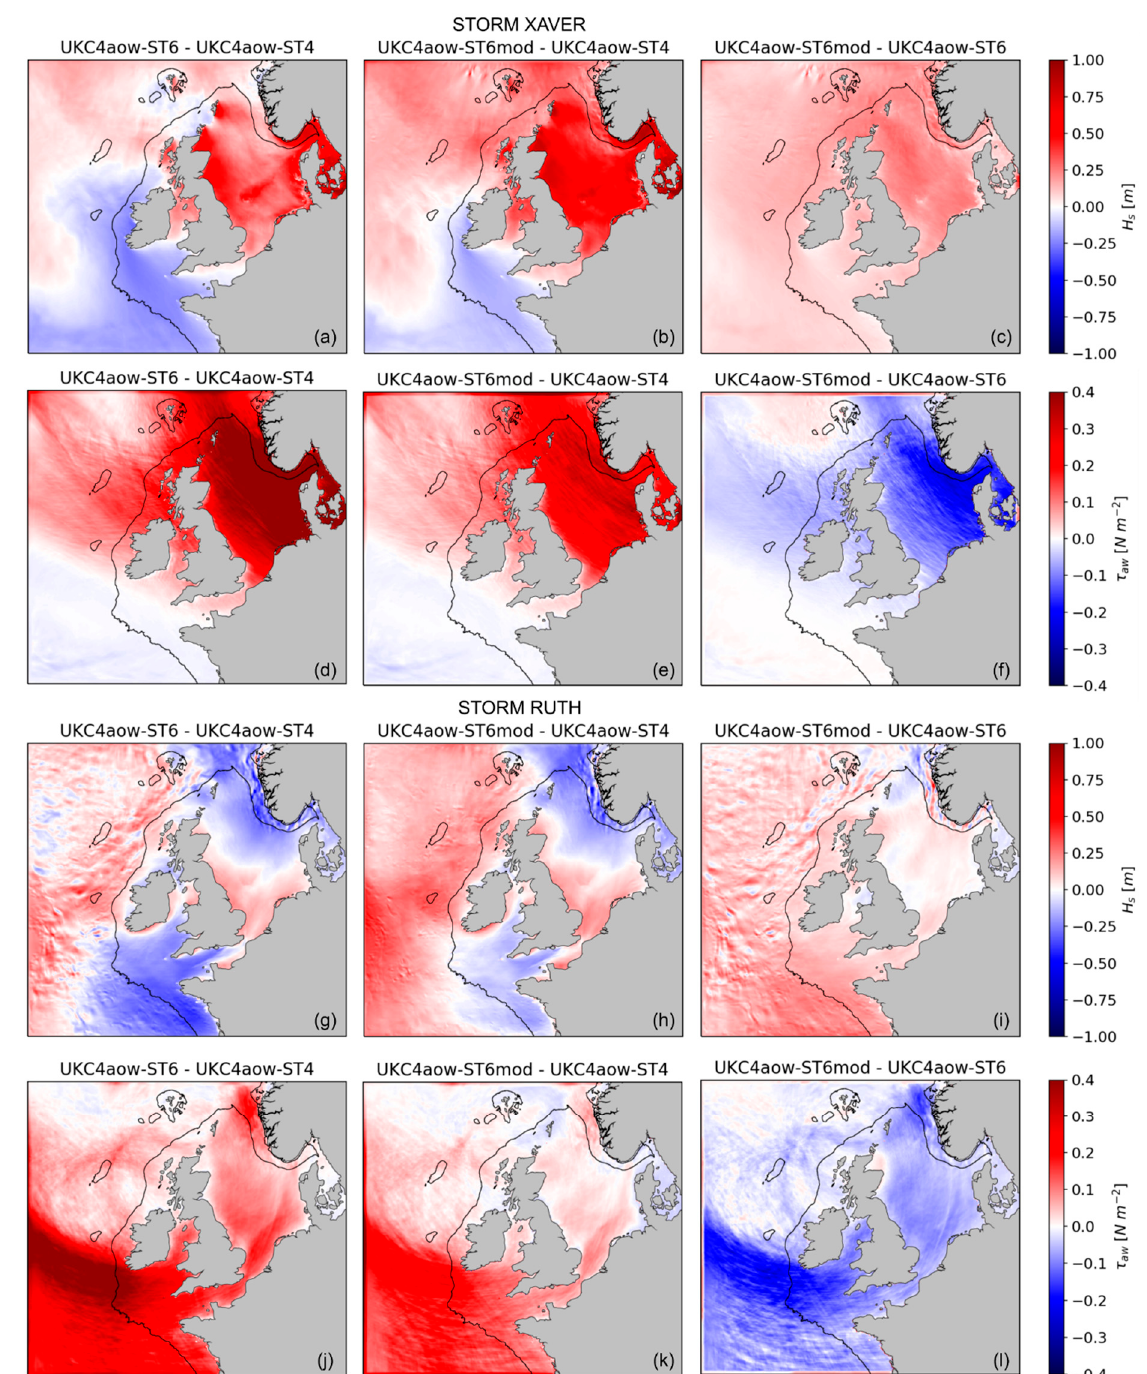
Figure 9. Mean difference in significant wave height ( H s ) and wave supported wind stress ( τ aw ) between the coupled-ST6 physics experiments #ST6 ( a , d , g , j ) and #ST6mod ( b , e , h , k ), and the coupled-ST4 physics UKC4aow model run; and between #ST6 and #ST6mod ( c , f , i , l ) during storm Xaver ( a – f ) and storm Ruth ( g – l ). The 200-m isobath (solid blue contour) is included to indicate the continental shelf